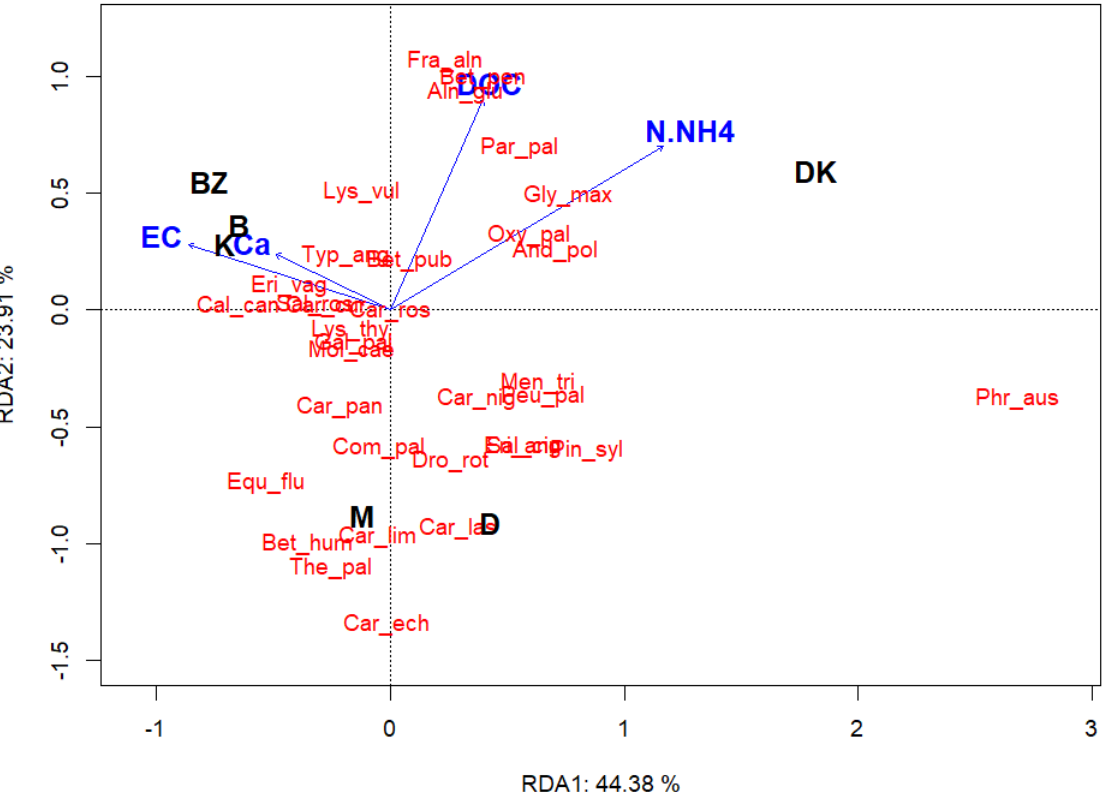
Figure 5. RDA triplot with fitted site scores (black), 43 species (red), and environmental variables (blue) as arrows. Two methods of scaling were used: (a) scaling = 1 and (b) scaling = 2. Key to abbreviations for site names: Lake Bikcze (B), Lake Karaśne (K), Lake Długie (D), Lake Moszne (M), the mid-forest bog Blizionki (BZ) and the Dekowina (DK) wetland sanctuary. Species names according to the caption for Figure